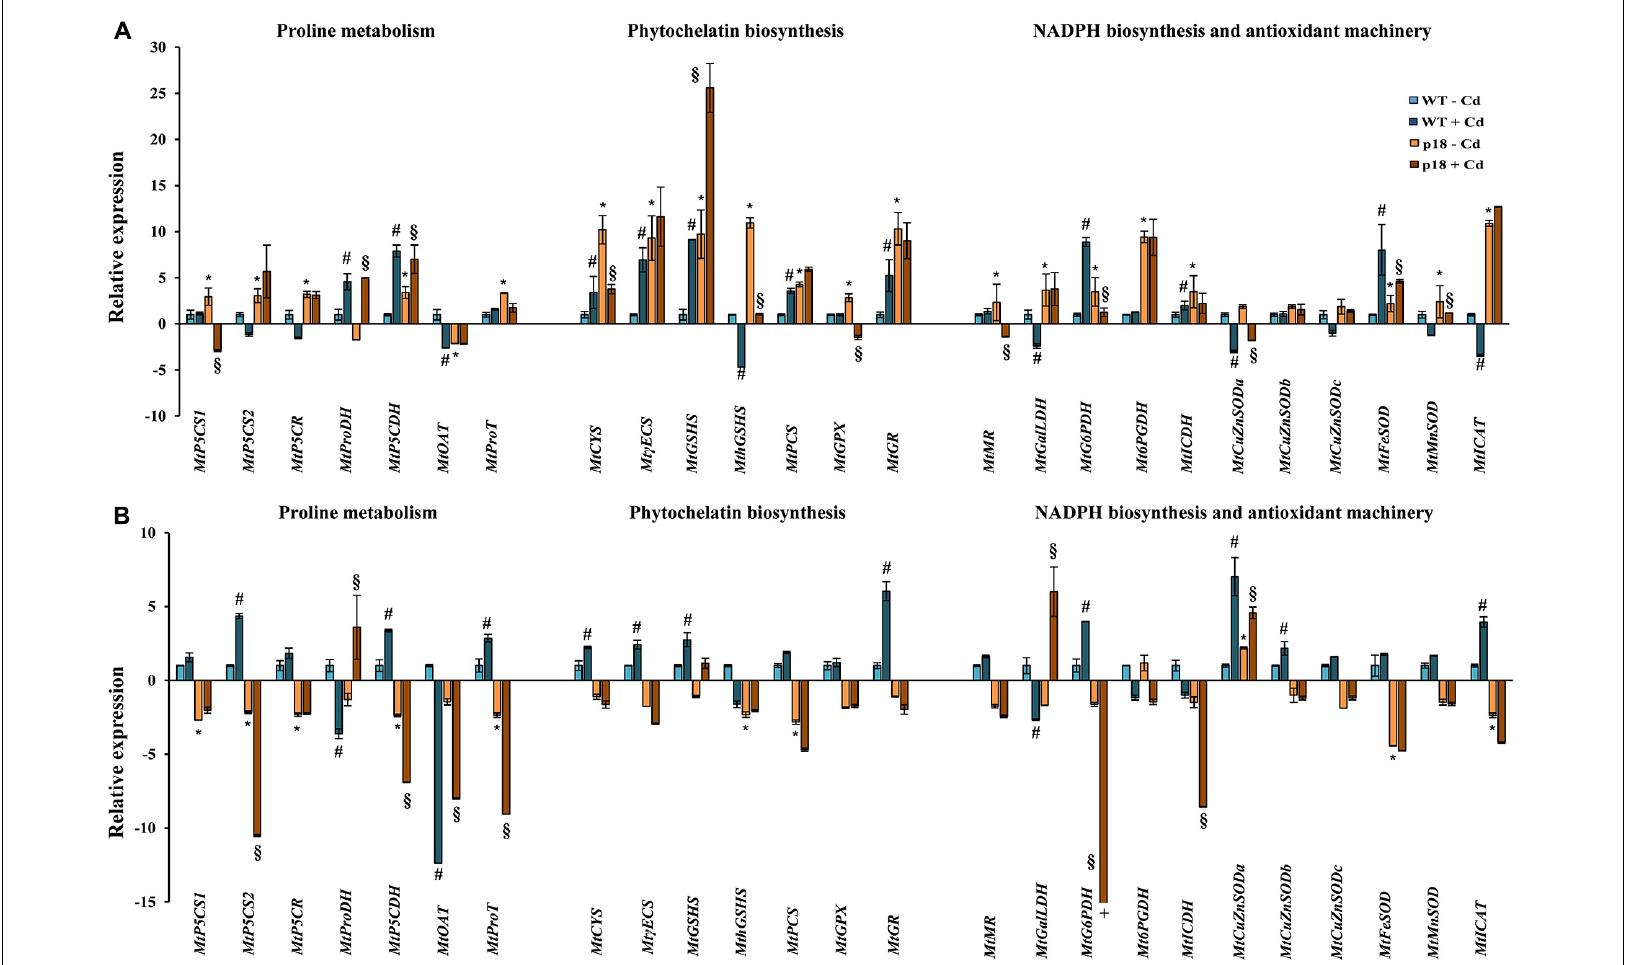
FIGURE 2 | Transcript accumulation of genes involved in Pro metabolism, PC biosynthesis, antioxidant machinery and NADPH biosynthesis in M. truncatula WT and transgenic p18 seedlings roots (A) and shoots (B) grown in the absence or presence of 50 µ M CdCl 2 for 12 h. Data are mean of four biological replicates (10 seedlings per replicate). * Indicates significant differences (fold change ≥ 2) between untreated WT and p18 seedlings; #, significant differences between untreated and Cd-treated WT seedlings; §, significant differences between untreated and Cd-treated p18 seedlings; + , the actual value is –37.8. Abbreviations: MtP5CS1 : M. truncatula (cid:49) 1 -pyrroline-5-carboxylate synthetase 1; MtP5CS2 : (cid:49) 1 -pyrroline-5-carboxylate synthetase 2; MtP5CR : pyrroline-5-carboxylate reductase; MtP5CDH : (cid:49) 1 -pyrroline-5-carboxylate dehydrogenase; MtProDH : proline dehydrogenase; MtOAT : ornithine δ -aminotransferase; MtProT : proline transporter; MtCYS : cysteine synthase; MtECS : γ -glutamylcysteine synthetase; MtGSHS : glutathione synthetase; MthGSHS : homoglutathione synthetase; MtPCS : phytochelatin synthase; MtGPX : glutathione peroxidase; MtGR : glutathione reductase; MtMR : monodehydroascorbate reductase; MtGalLDH : galactono-1, 4-lactone dehydrogenase; MtG6PDH : glucose-6-phosphate dehydrogenase; Mt6PGDH : 6-phosphogluconate dehydrogenase; MtICDH : isocitrate dehydrogenase; MtCuZnSODa , MtCuZnSODb , MtCuZnSODc : cooper/zinc superoxide dismutases; MtFeSOD: ferric SOD; MtMnSOD : manganese SOD; MtCAT :